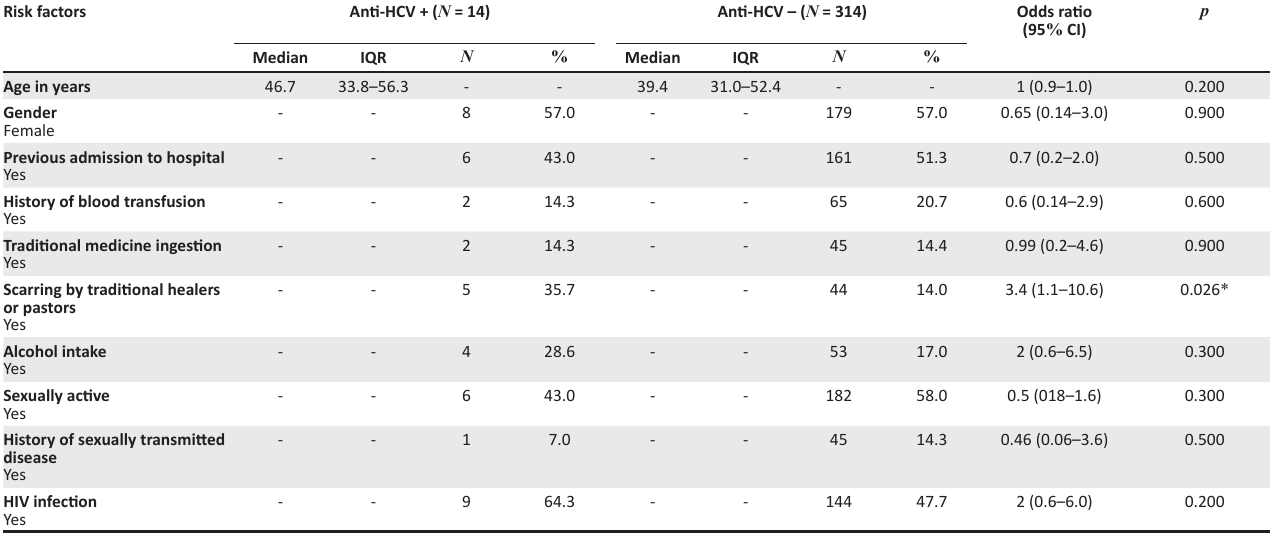
TABLE 2 : Risk factors in patients with positive antibody to hepatitis C